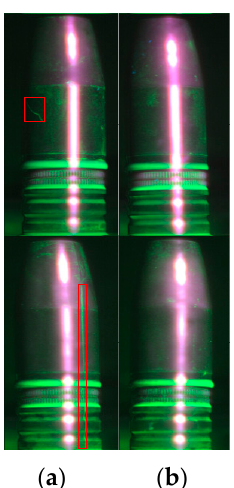
Figure 7. Examples of the fluorescent magnetic powder surface defects dataset. The defect areas are labeled by the red bounding boxes. ( a ) bad; ( b ) good.